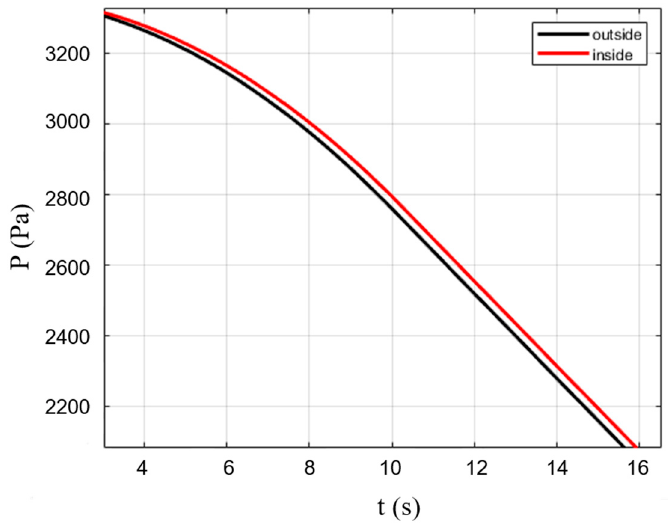
Figure 14. Air pressure change value curves inside and outside the car without the ventilation system.